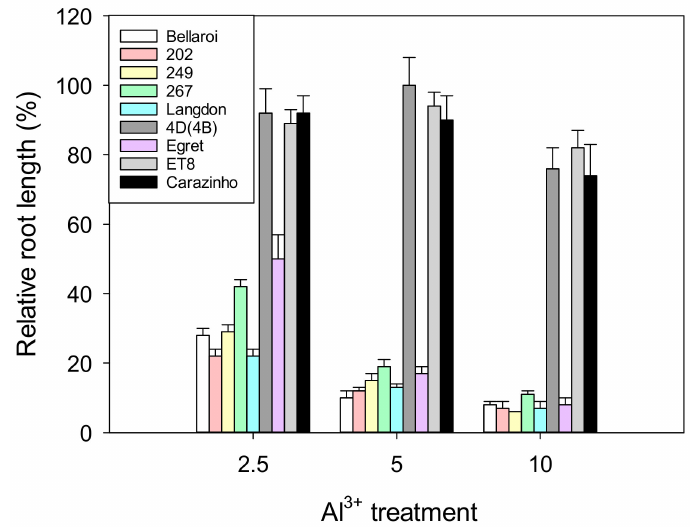
Figure 7. Relative Al 3 + tolerance of durum wheat genotypes previously identified as being relatively Al 3 + tolerant in comparison to a durum substitution line with chromosome 4D of bread wheat and bread wheat lines possessing Al 3 + -tolerant and -sensitive alleles of the TaALMT1 gene. Bellaroi is an Australian durum wheat cultivar; lines 202, 249, and 267 are accessions previously classified as being Al 3 + -tolerant durum genotypes [26]; Langdon is the parental durum cultivar used to generate the 4D substitution line; 4D (4B) is a durum line in the Langdon background where chromosome 4B has been substituted with chromosome 4D; Egret is an Al 3 + -sensitive bread wheat cultivar; ET8 and Carazinho are Al 3 + -tolerant bread wheat lines. Root length is expressed as percent relative to a zero control and error bars indicate cumulative errors of three to five